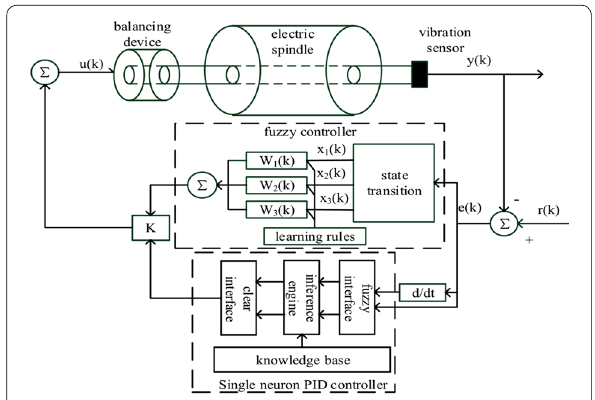
Figure 24 Schematic diagram of fuzzy self-tuning single neuron PID control